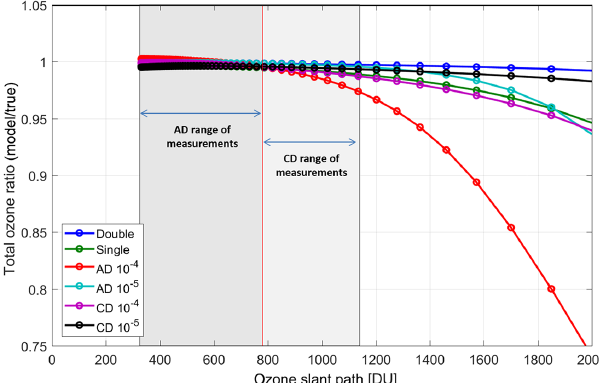
Figure 4. Ratio of the values retrieved from modeled single and double Brewers as well as a Dobson instrument with different lev- els of stray light (the numbers in front of the pairs show the levels of stray light) to assumed 325DU ozone in the atmosphere (see text for details). The calculations reported in this study for the BP absorp- tion coefficients have been used to retrieve total ozone. It should be noted that the air mass factor range recommended for AD measure- ments is 1.015 to 2.5 or less than 800DU OSP and for CD measure- ments is 2.4 to 3.5 or less than 1200DU OSP (Evans and Komhyr,